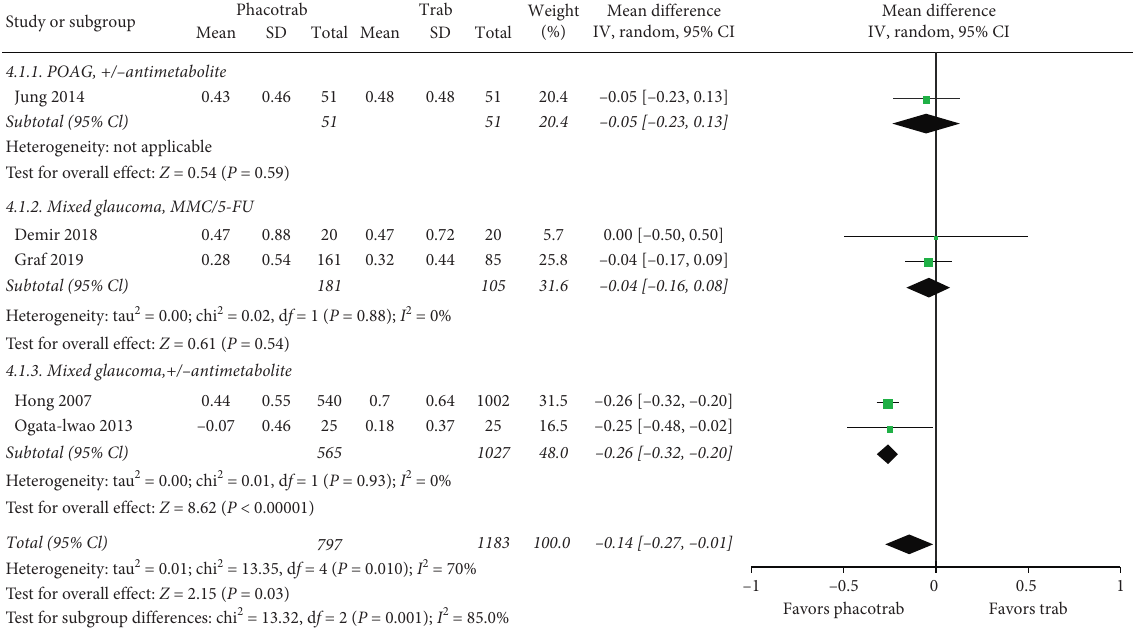
Figure 4: Forest plot of the visual acuity after phacotrabeculectomy versus trabeculectomy only. CI � confidence interval; d f � degrees of freedom; IV � inverse variance; SD � standard deviation. MMC � mitomycin c; 5-FU � 5-fluorouracil; +/ − antimetabolite � not all eyes received